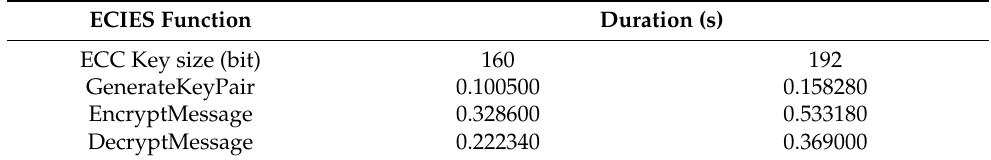
Table 5. Measurements of the executed ECIES functions by the Industruino devices.